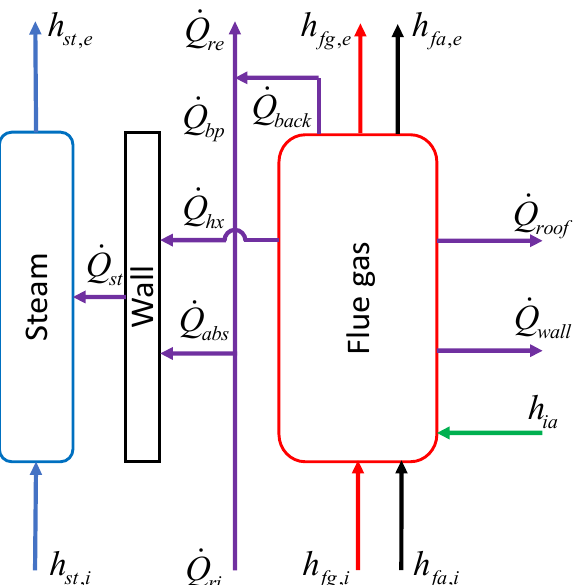
Figure 2. Heat transfer phenomena and energy flow paths in a generic radiative/convective heat exchanger.